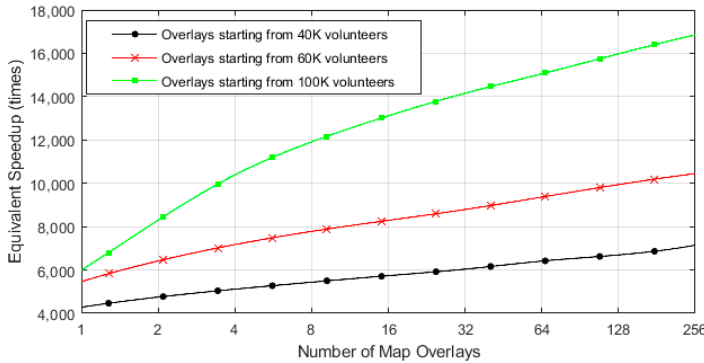
Figure 10. The equivalent speedup vs. the number of map overlays.